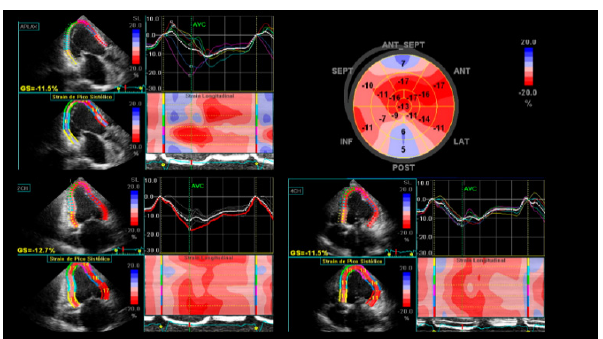
Figure 1. Global longitudinal strain of the left ventricle and strain curves depicting increased mechanical dispersion. Abnormal findings of left ventricular (LV) longitudinal strain in apical three-chamber view (top left); apical two-chamber view (bottom left); apical four-chamber view (bottom right); “Bull’s-eye” plot of strain values for each myocardial segment evidences anteroseptal and inferolateral akinesia represented by blue areas in the polar map (top right).